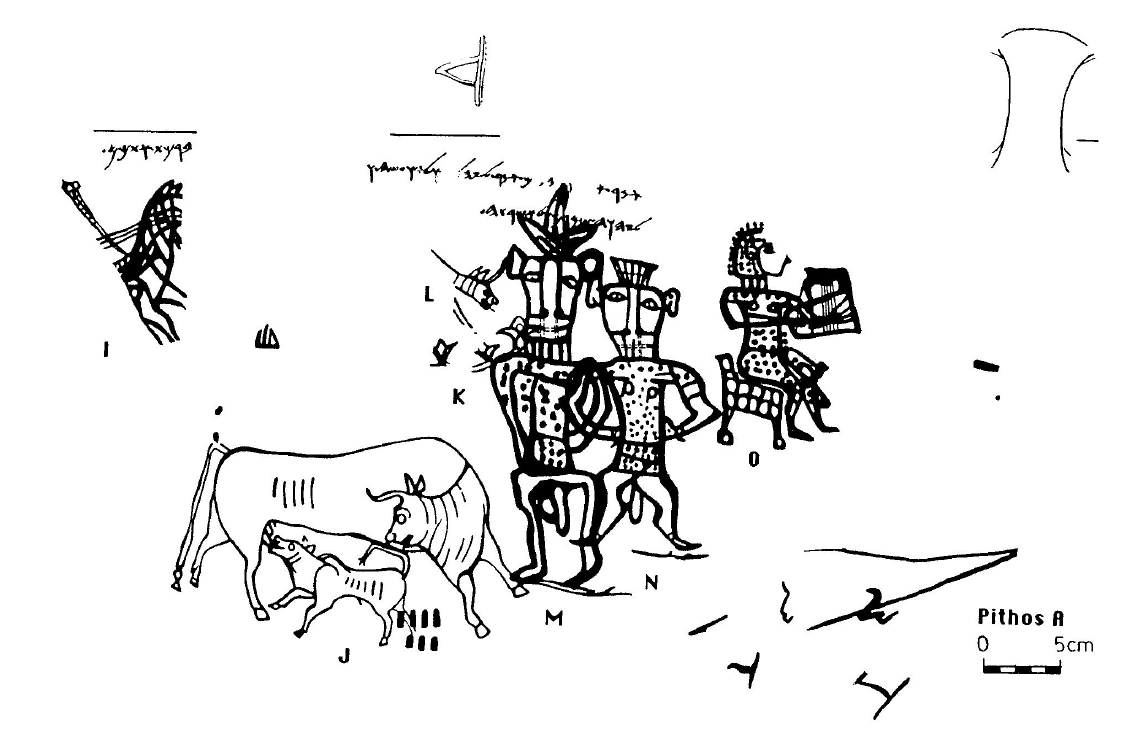
Figure 8 Drawings on Pithos A (Kuntillet Ajrud, Iron Age